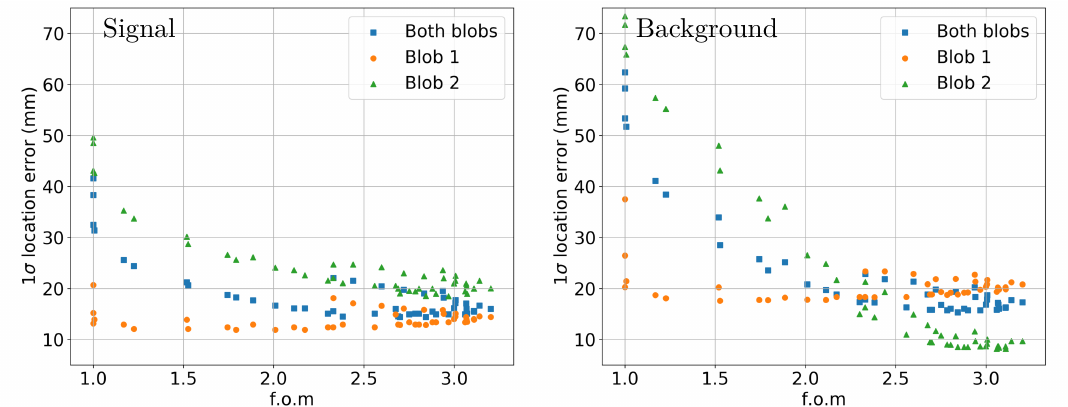
Figure 20 . Blob location error distance, defined in the text, for all configurations of the RL parameter scan and as a function of the best f.o.m. value achieved with such configuration. Left: location error for signal events within the double escape peak ROI. Right: background events in the same ROI.